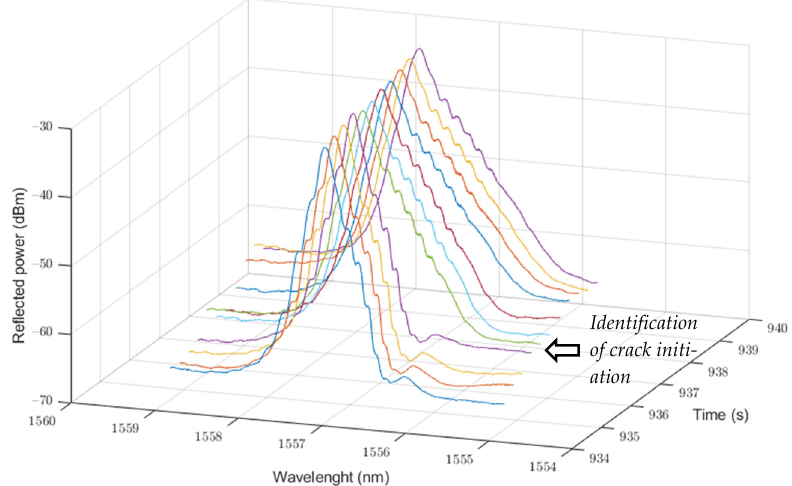
Figure 10. Sensor 3 FBG spectrum change at first 0.25–0.75% strain cycle.